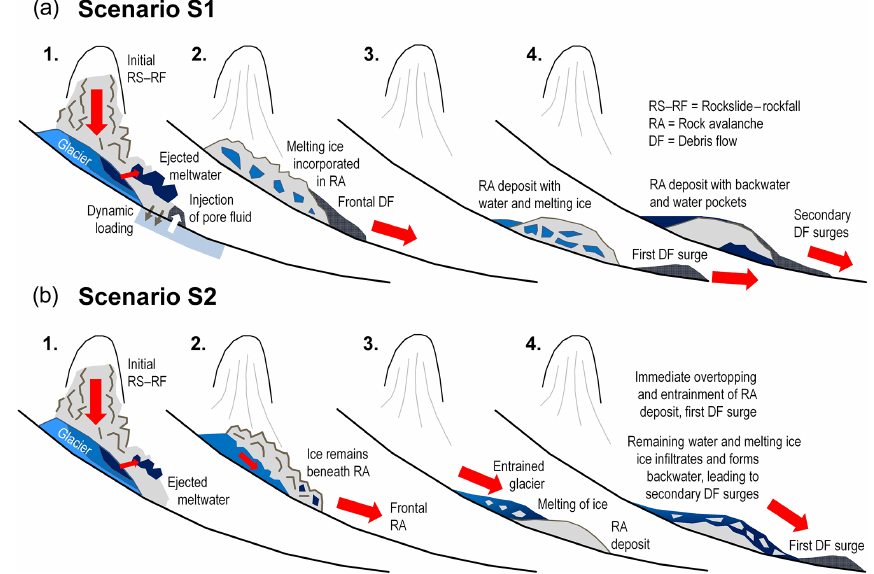
Figure 6. Qualitative conceptual models of the rock avalanche–debris flow transformation. (a) Scenario S1. (b) Scenario S2. See text for the detailed description of the two